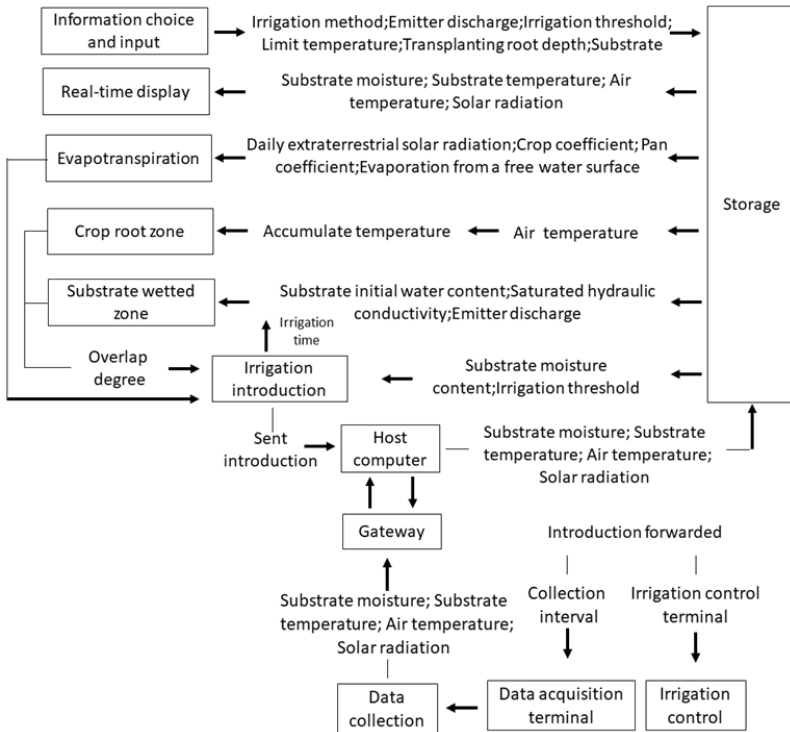
Figure 2. Flow diagram for the proposed control algorithm.